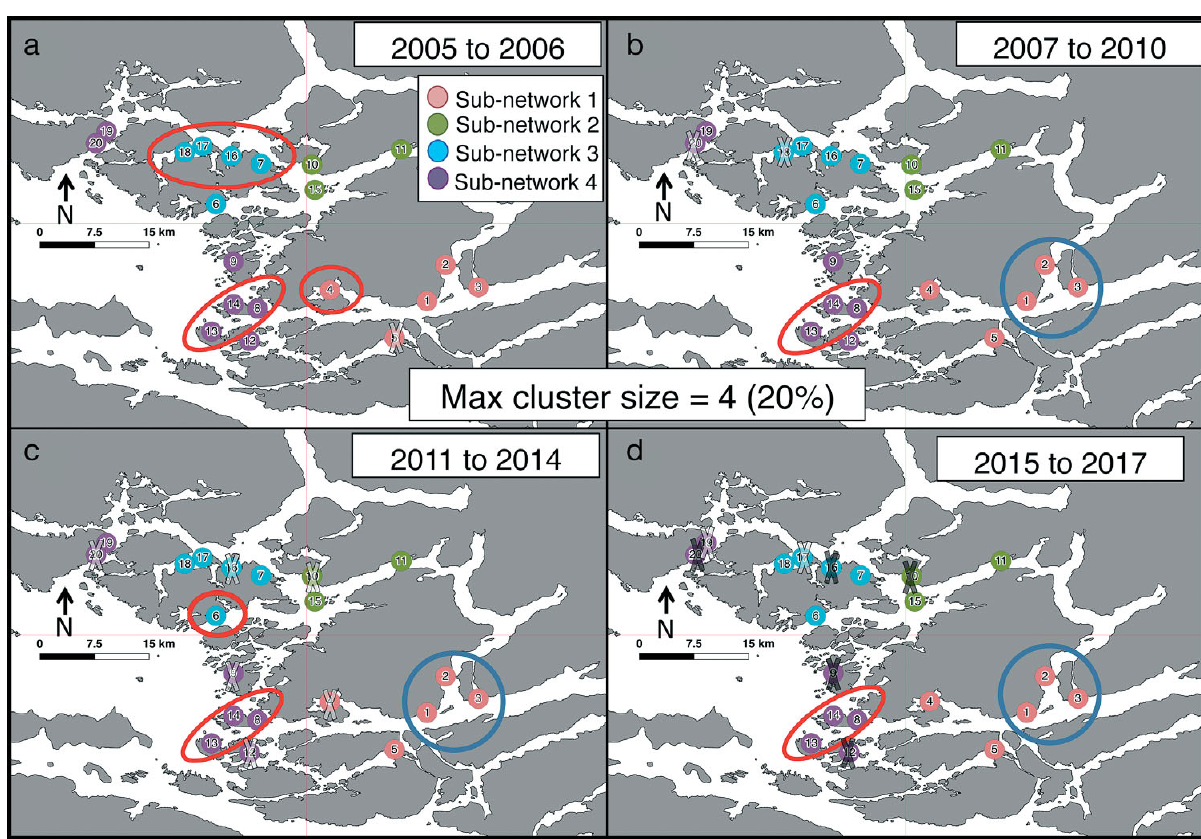
Fig. 4. SaTScan results from a window that may include up to 20% of farms, with significant (p < 0.05) high-risk (red) and low- risk (blue) clusters of farms for sea lice counts (log-transformed) over the study period. The analyses were carried out with monthly time steps and summarised by years (inclusive) to capture overall trends through time: (a) 2005−2006; (b) 2007−2010; (c) 2011−2014; (d) 2015−2017. Black, semi-translucent ‘X’s placed on farms indicate the farm was not active for the entire du- ration of time period represented in the panel; light grey ‘X’s indicate the farm was not active for some duration of the time period represented in the